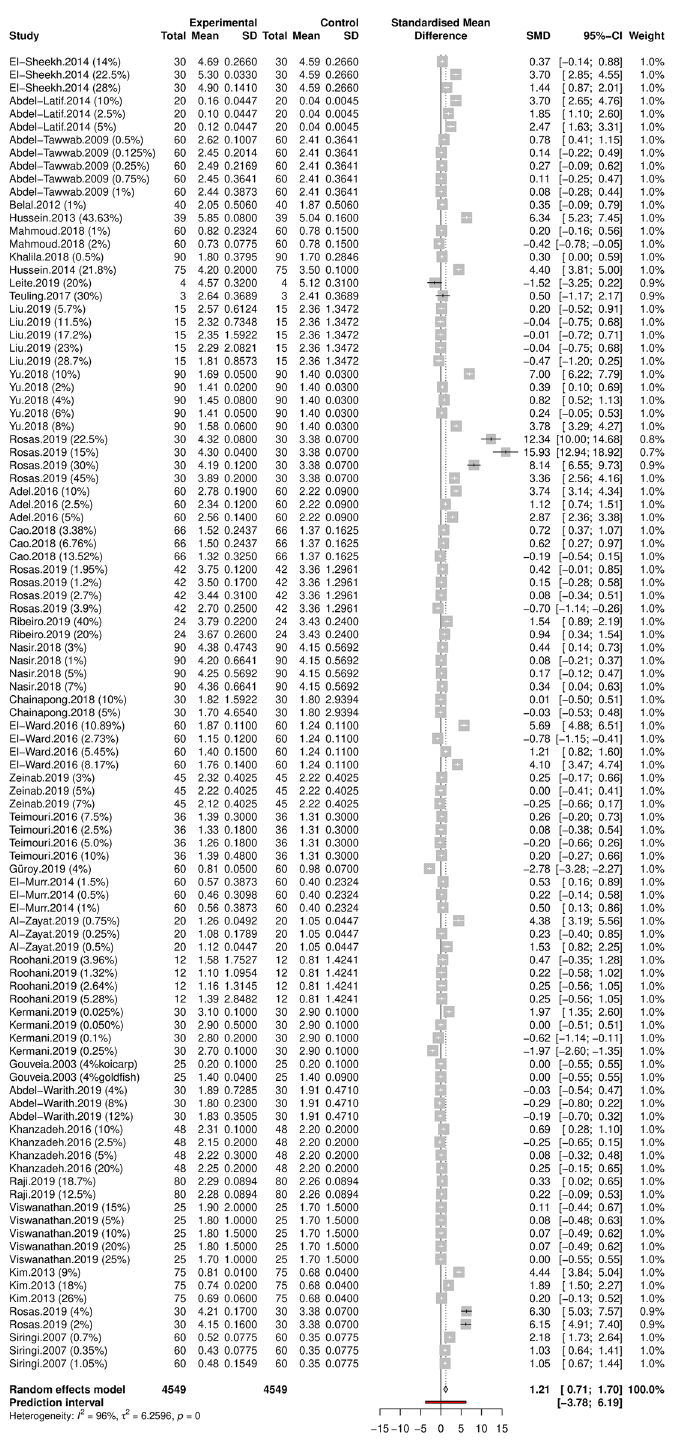
Figure 2. Forest plot summarizing the effect of Spirulina replacement on the Specific Growth Rate (SGR) of farmed finfish. Each trial (n = 101) is represented by a square whose size is proportional to its relative weight, its width represents the 95% CI, the horizontal line the 99% CI, and the center the Standardized Mean Difference (SMD) corrected for small sample size (Hedge’s g ). The grey diamond at the bottom represents the overall effect extending over the 95% CI. The solid vertical line denotes the zero effect, and the dotted vertical line the SMD under a random effects